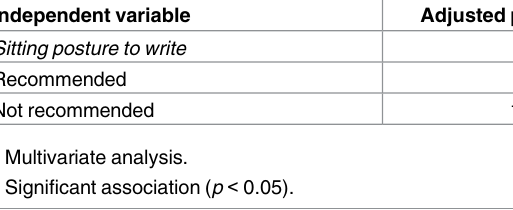
S1 Table. Datasets of